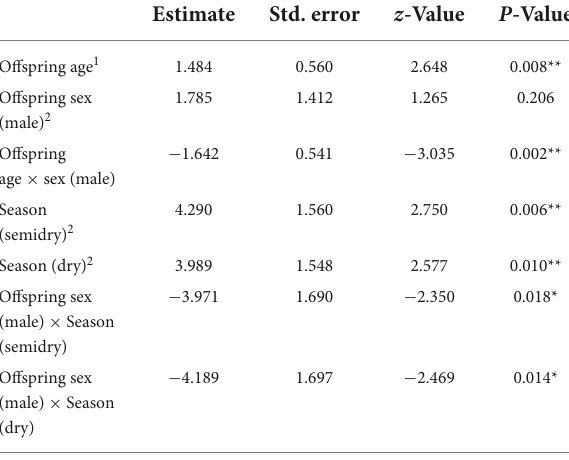
TABLE 2 The result of the binomial Generalized Linear Mixed Model (GLMM) investigating the effect of offspring age, sex, and season on the offspring Hylobates moloch co-singing with their mothers in Gunung Halimun-Salak National Park, Indonesia from 2009 to 2021.